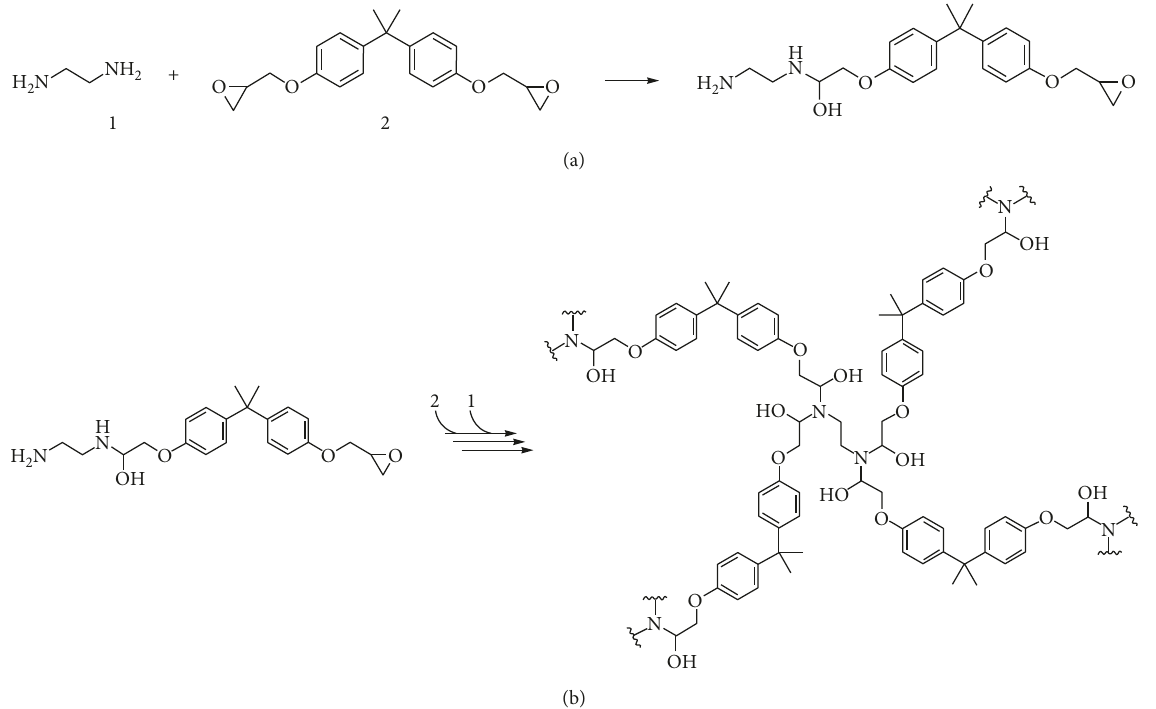
Figure 1: A few steps of the polymerization reaction between one EDA (1) and one DGEBA (2) monomer (a), leading to the fi nal cross-linked structure